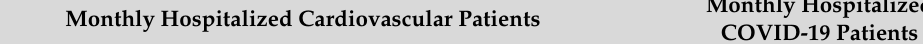
Table 1. Absolute and relative development of monthly hospitalized cardiovascular and COVID-19 patients of Marburg University Hospital,